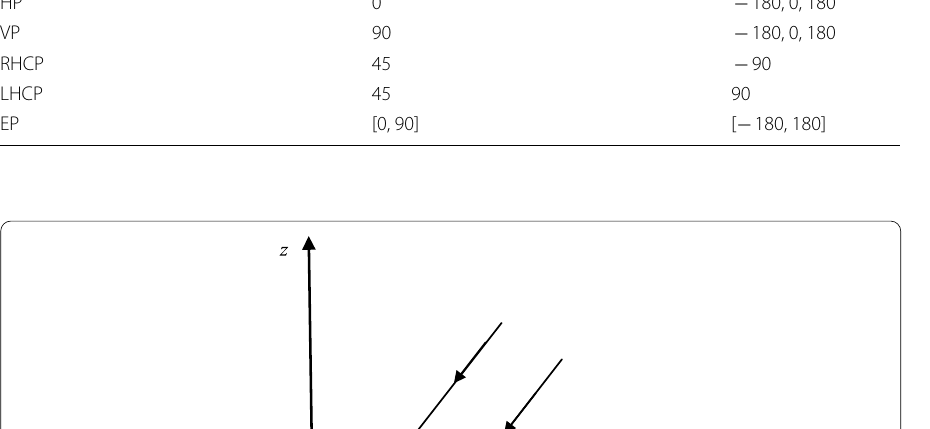
Table 1 The parameters for different polarization modes Polarization mode